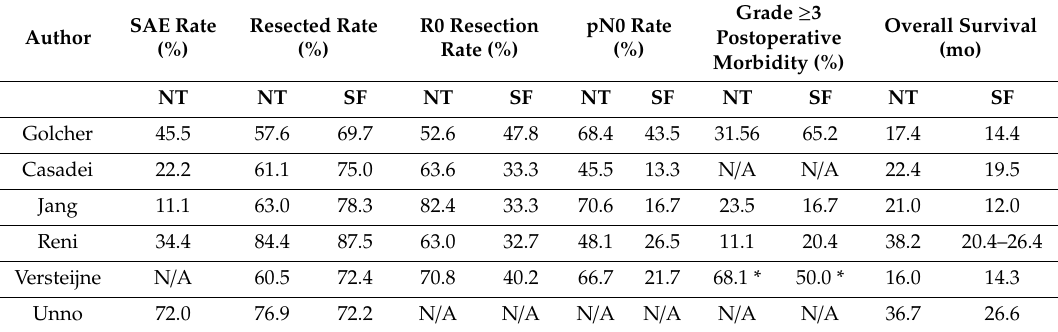
Table 2. Outcomes of randomized controlled trials included in the meta-analysis.